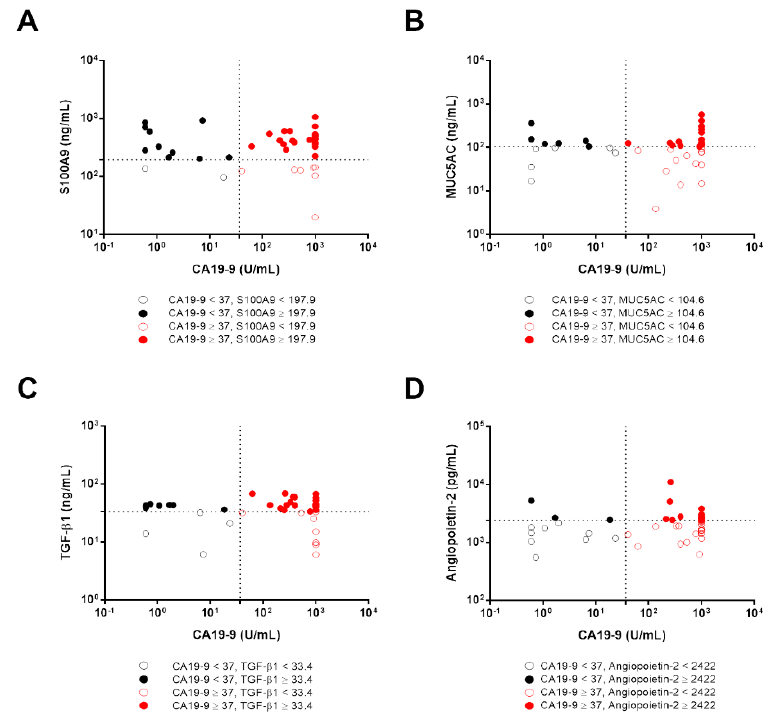
Figure 4. Biomarkers panel in CCA patients with CA19-9 low levels. The scatter plots indicated the distribution of CA19-9 levels and candidate biomarkers including S100A9 ( A ), MUC5AC ( B ), TGF- β 1 ( C ), and angiopoietin-2 ( D ) in patients diagnosed with CCA. The optimal cut-off levels of S100A9, MUC5AC, TGF- β 1, angiopoietin-2, and CA19-9 were 197.9 ng/mL, 104.6 ng/mL, 33.4 ng/mL, 2422 pg/mL, and 37 U/mL, respectively.